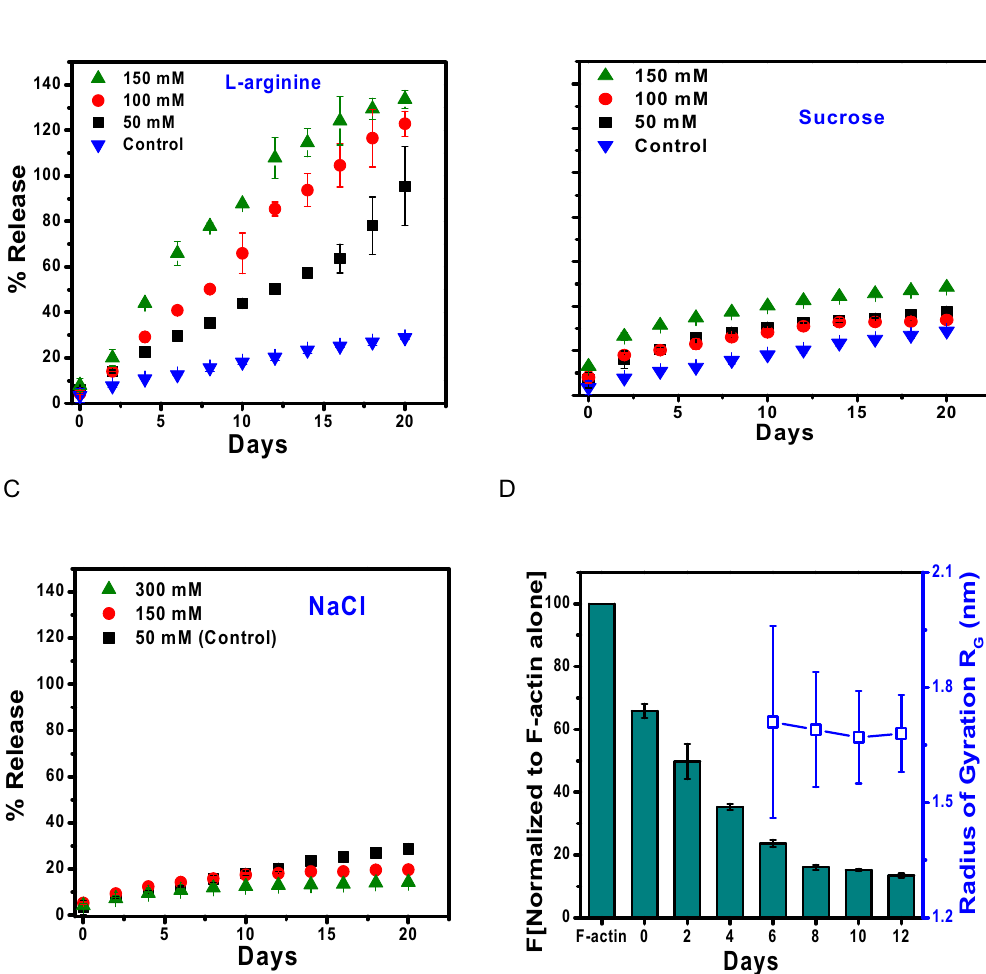
Figure 7. ( A – C ) Release profile of soluble versions of 28–161 from heat induced β -amyloids are presented here in presence of varying amounts of L-arginine or Sucrose or NaCl. ( D ) The F-actin depolymerization activity of the supernatant released in presence of 50 mM of L-Arg and sample’s R G value as characterized by Guinier analysis of 20X concentrated supernatant are